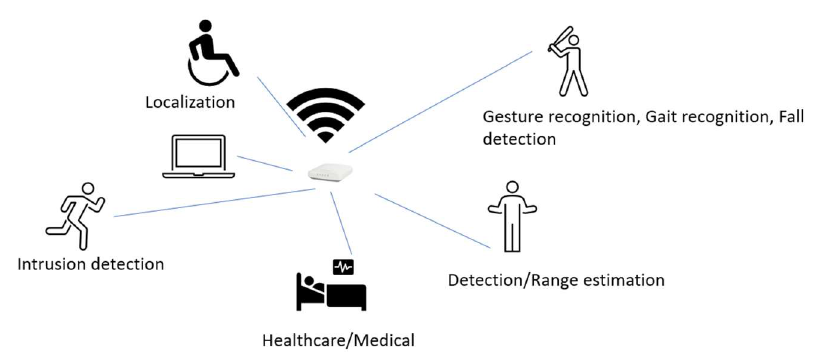
Figure 12. WiFi sensing may be used for many different applications: Localization, intrusion detection, health and medical monitoring, range detection and estimation, gesture recognition, gain recognition, and fall detection.